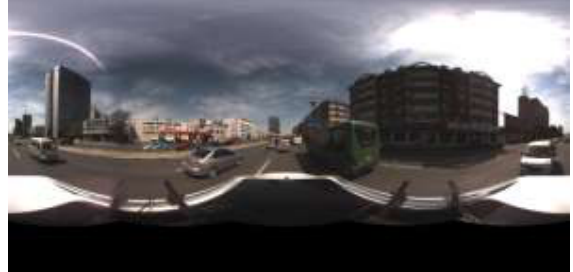
Figure 2. Largely distorted equirectangular panoramic image